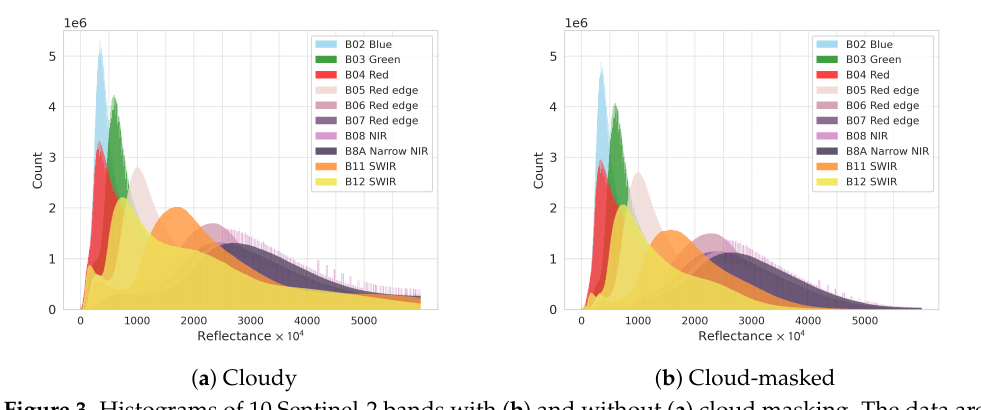
Figure 3. Histograms of 10 Sentinel-2 bands with ( b ) and without ( a ) cloud masking. The data are from the growing season (May–August 2020) of all field parcels in the study sample. Note that the range of the surface reflectance values is set to [1, 6000]. The number of bins is 1000.